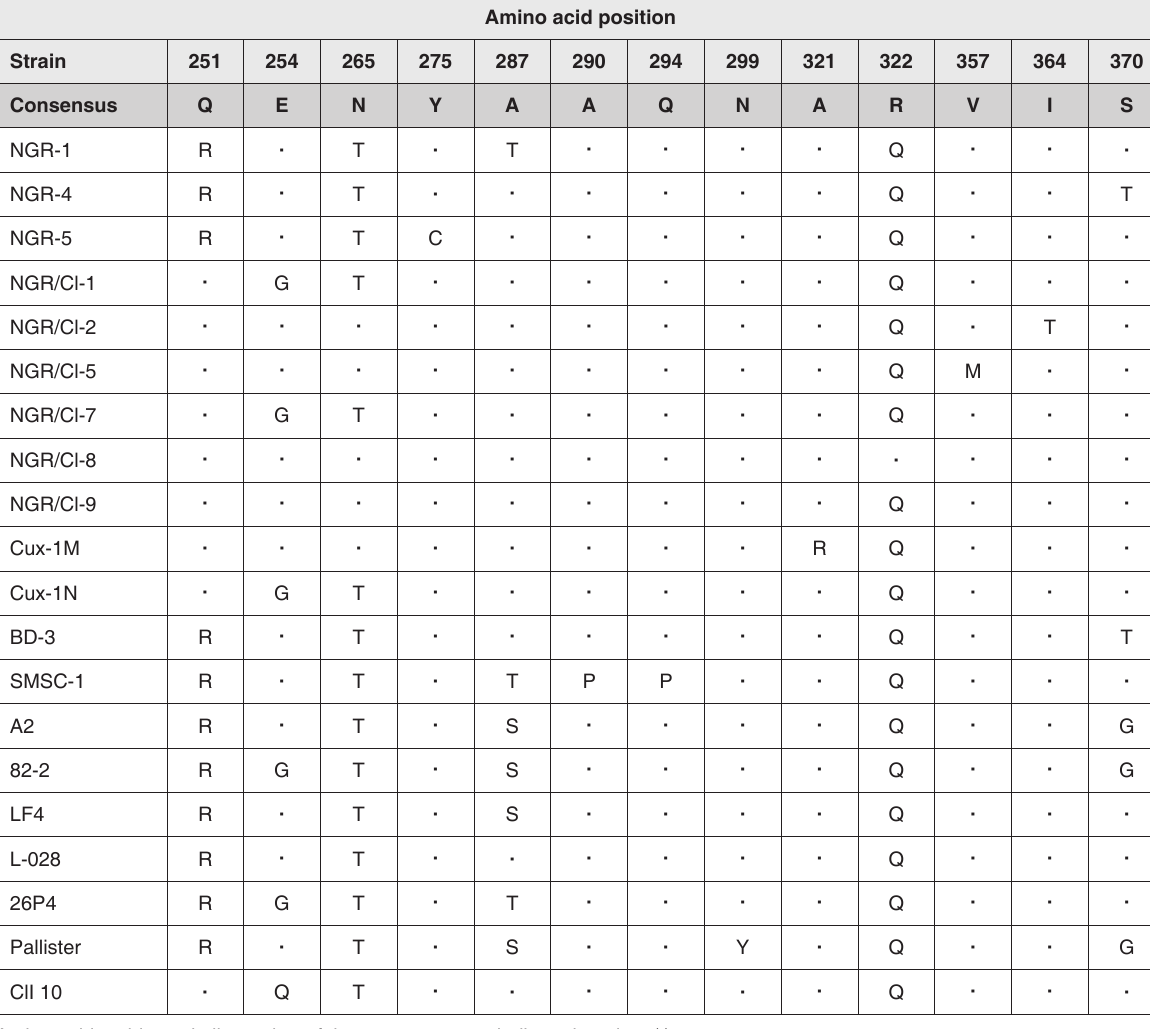
TABLE 2 Amino acid differences between Nigerian and reference CAV strains (Numbering according to Meehan et al .